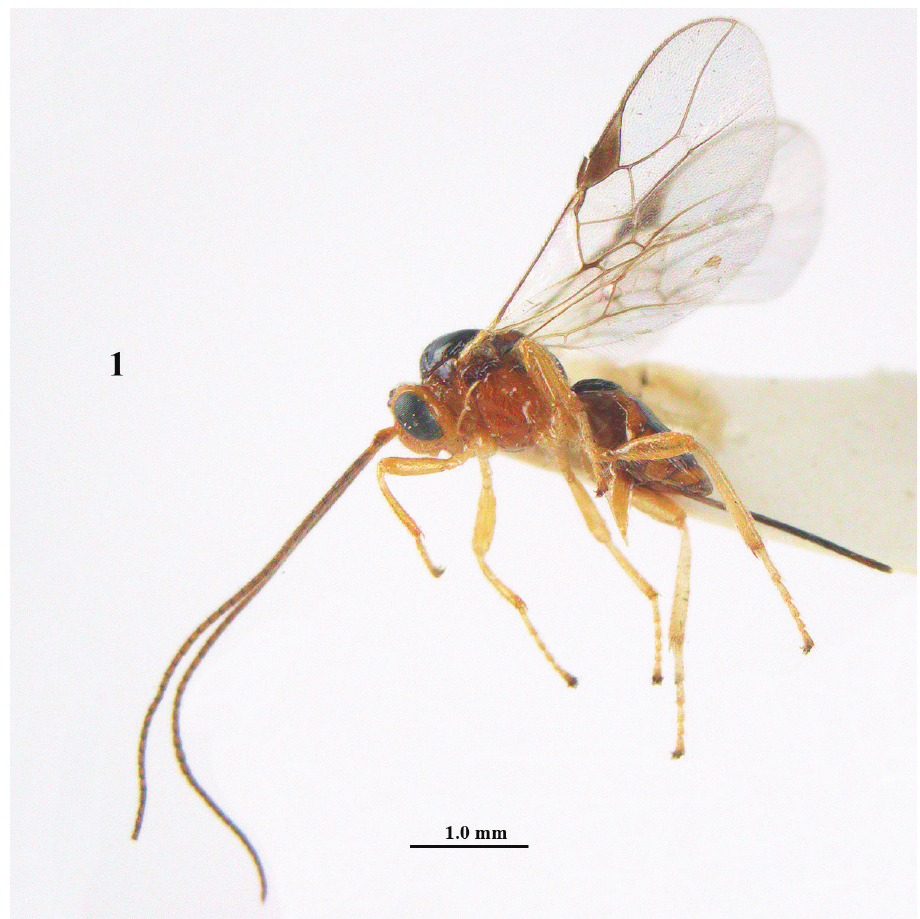
Figure 1. Psyttalia carinata (Thomson), ♀ , holotype of Opius brevitemporalis Tobias, habitus lateral.